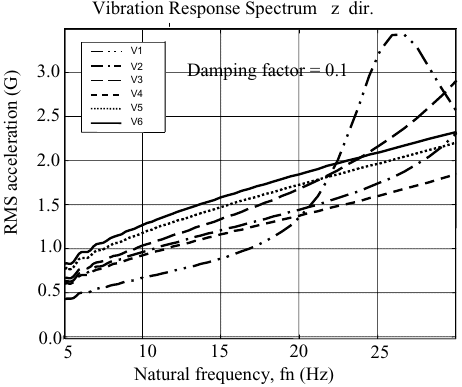
Fig. 7. Predicted RMS acceleration response of the HDD